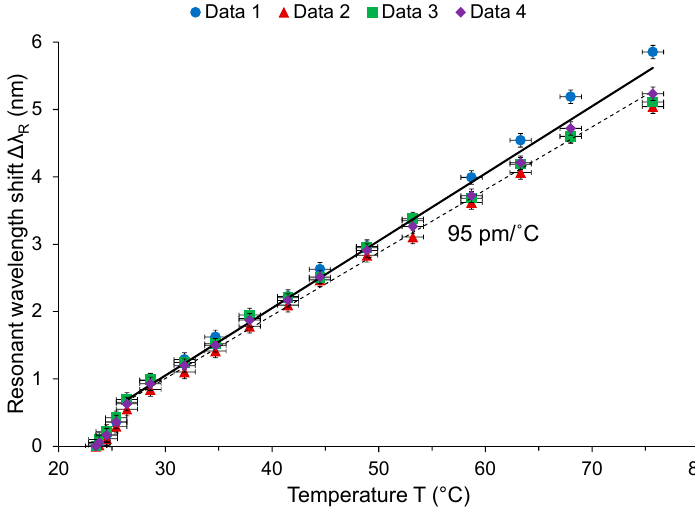
Figure 14. Measured sensitivity with an average linear fit (i.e., dashed line), compared with the simulated sensitivity (i.e., solid line).